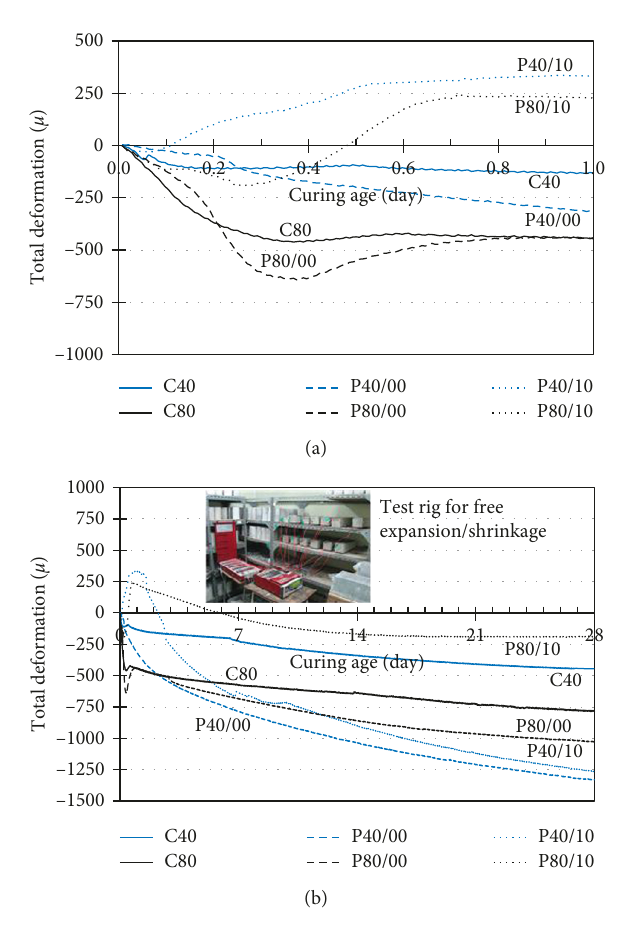
Figure 3: Free expansion-shrinkage strain of concrete and PE-SHCC prisms. (a) Free strain history during 1 day. (b) Free strain history during 28